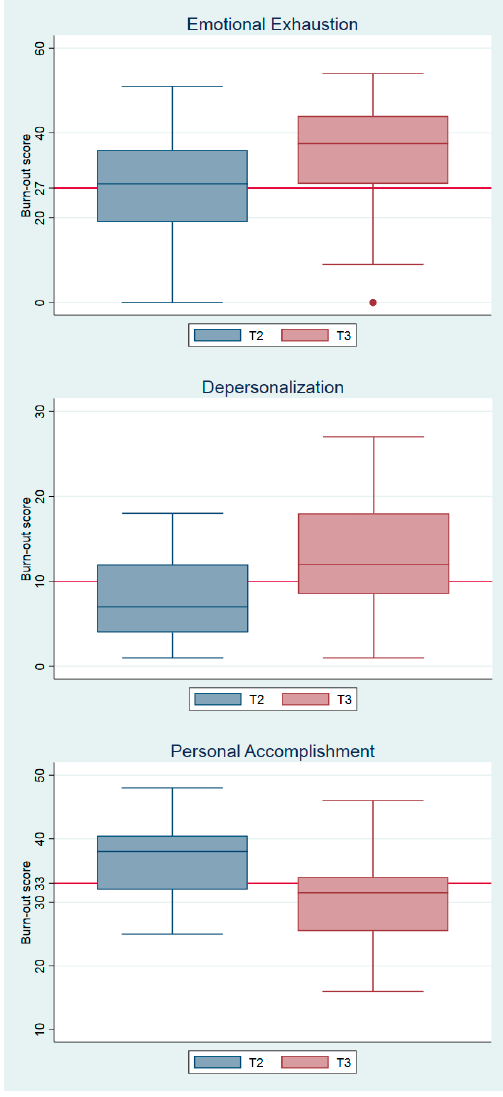
Figure 1. Burnout score for each